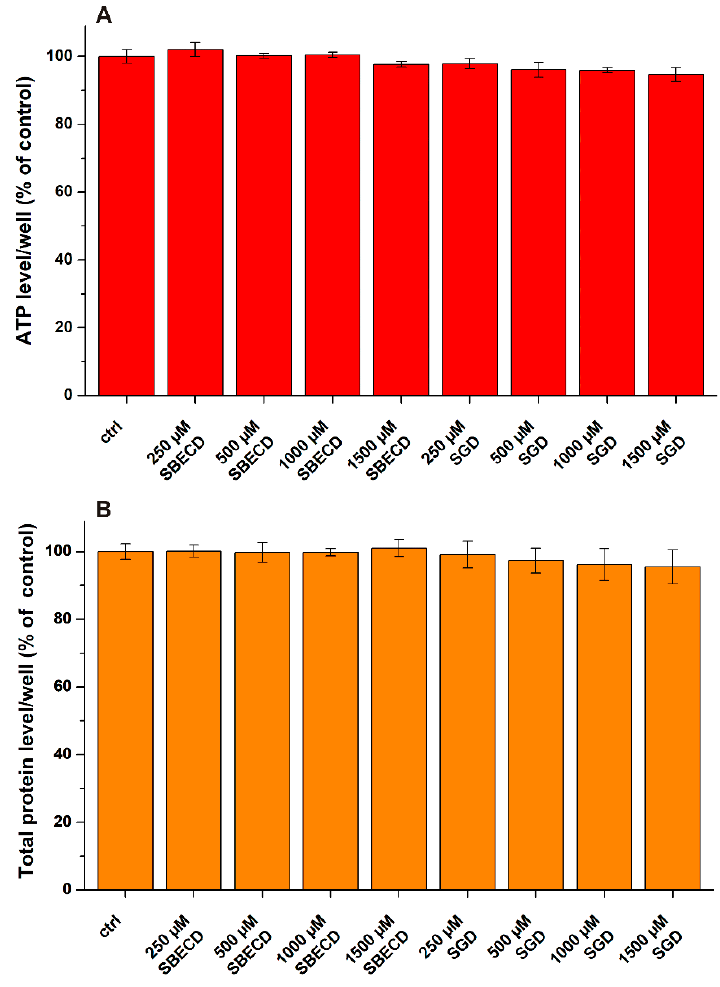
Figure 2. Effects of SBECD and SGD on cellular ATP ( A ) and total protein ( B ) concentrations. SH-SY5Y cells were treated with CDs (0–1500 µM) for 24 h. Data represent the means ± SEM ( n = 3).